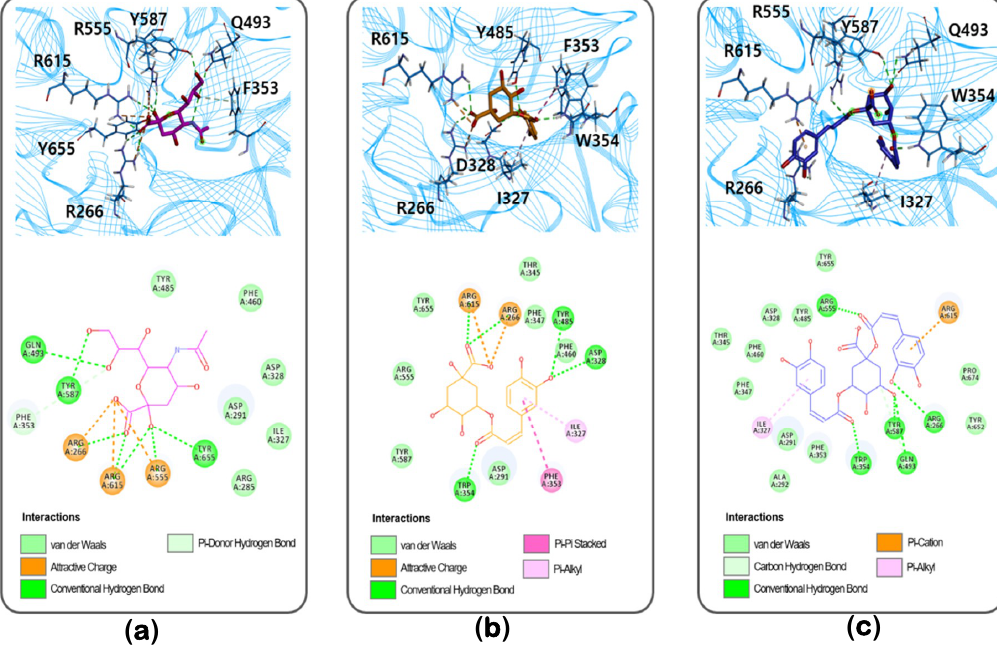
Figure 4. Docking poses of ( a ) n -acetylneuramic acid, ( b ) 5- O -caffeoylquinic acid, and ( c ) 1,5-di- O - caffeoylquinic acid. The 3D- and 2D-structures represent receptor-ligand interaction. N -Acetylneuramic acid, 5- O -caffeoylquinic acid, and 1,5-di- O -caffeoylquinic acid are represented as purple, orange, and blue stick models, respectively.